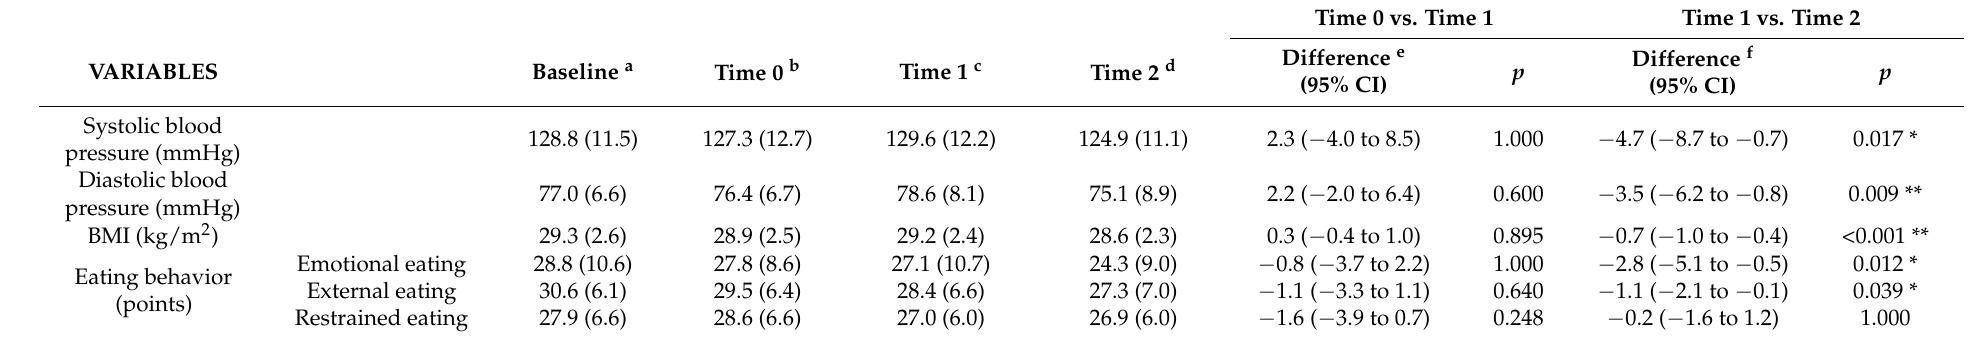
Table 2. Comparisons for Time 0 versus Time 1 versus Time